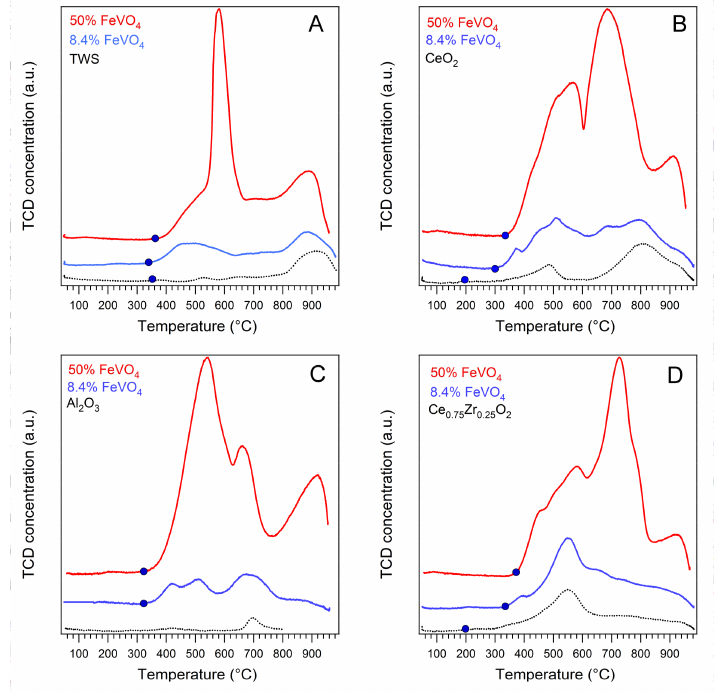
Figure 3. H 2 -TPR temperature-programmed reduction under H 2 atmosphere profiles of ( A ) FeVO 4 /TWS; ( B ) FeVO 4 /CeO 2 ; ( C ) FeVO 4 /Al 2 O 3 ; ( D ) FeVO 4 /Ce 0.75 Zr 0.25 O 2